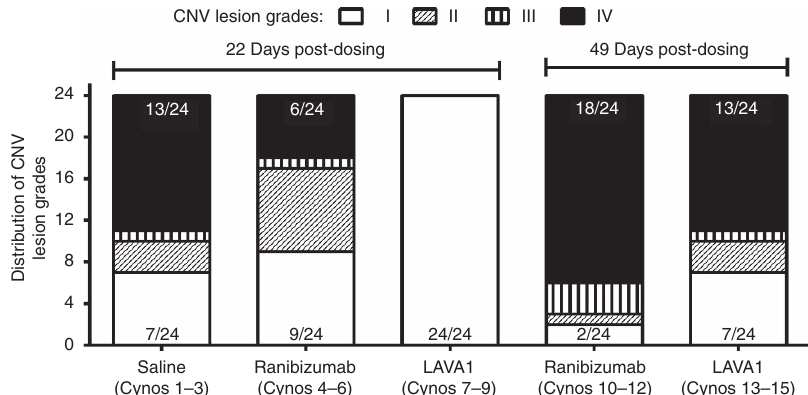
Figure 5 | Distribution of average CNV lesion grades. In the cohort of monkeys that were imaged 22 days post dosing, eyes that received ranibizumab had six grade IV lesions, whereas none of the eyes that received LAVA1 had grade IV lesions (all lesions were grade I). In the cohort of monkeys that were imaged 49 days post dosing, eyes that received ranibizumab had 18 grade IV lesions, whereas eyes that received LAVA1 had 13 grade IV lesions.